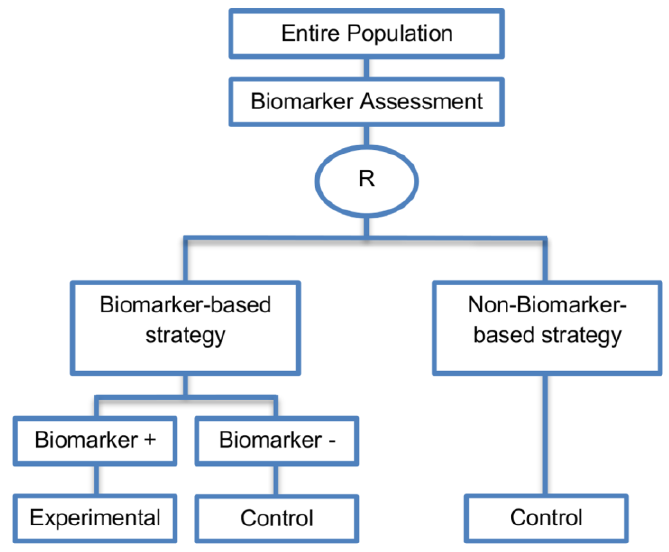
Figure 12. Biomarker-strategy design with biomarker assessment in the control arm. “R” refers to randomization of patients.